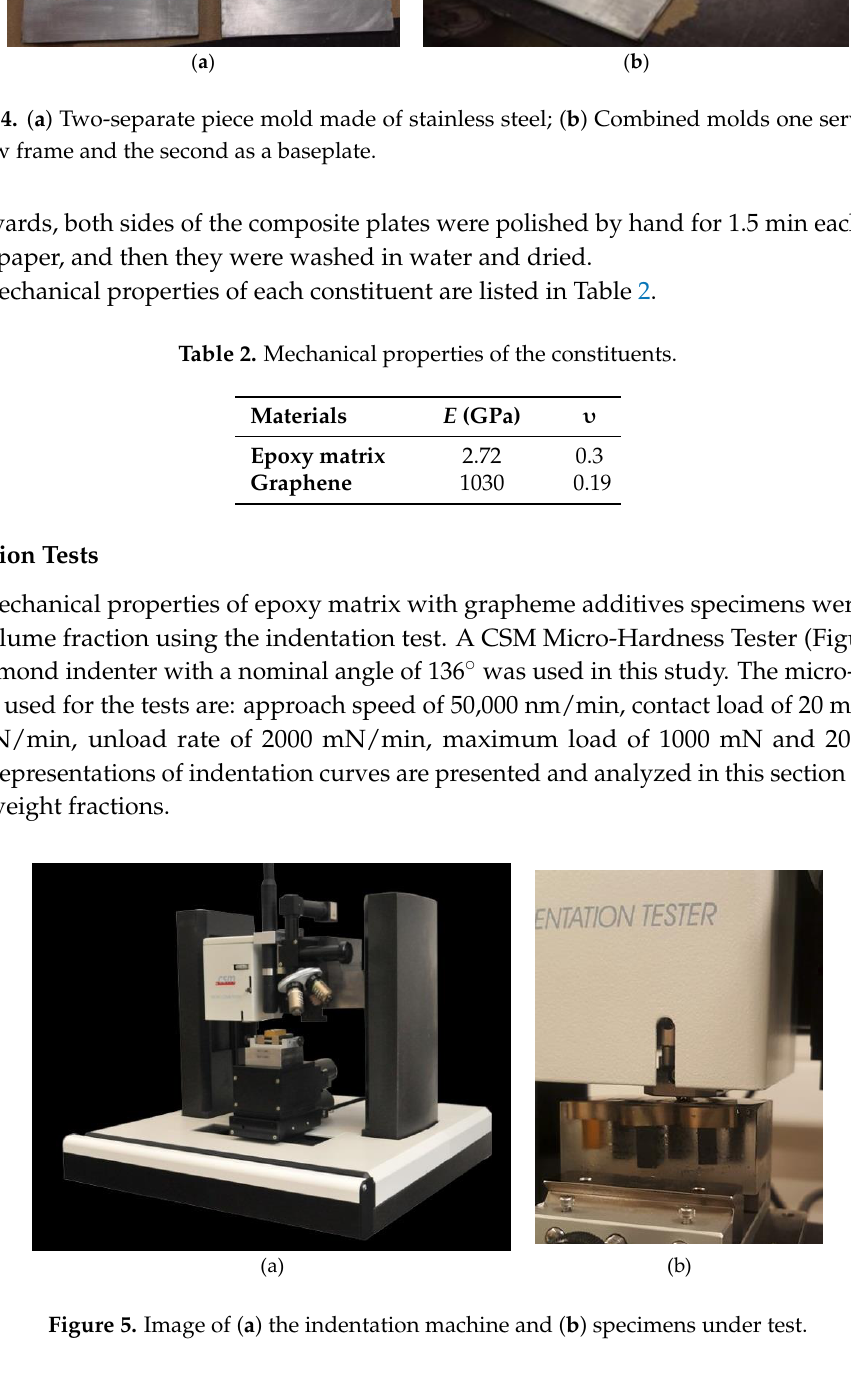
Figure 5. Image of ( a ) the indentation machine and ( b ) specimens under test.